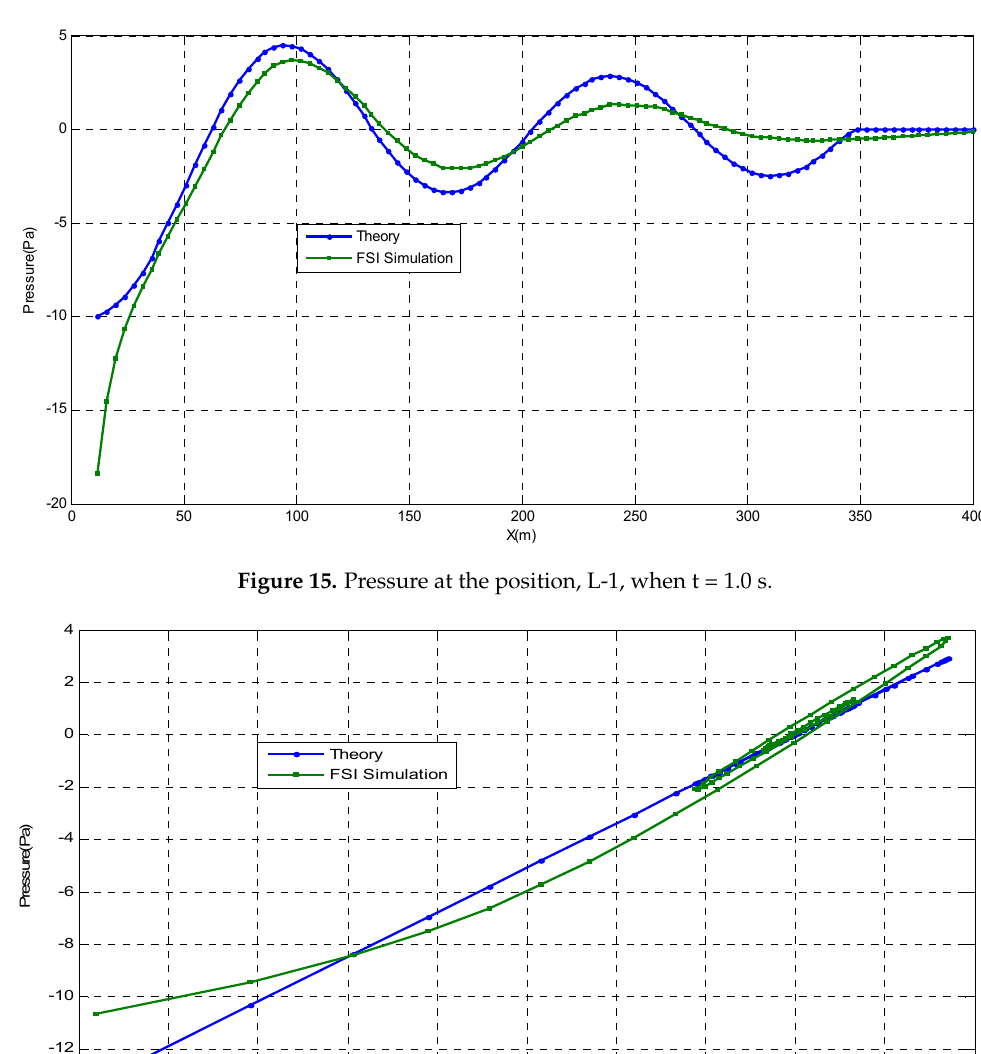
Figure 14. The velocity response in the y-direction of the circular shell when t = 1.0 s.